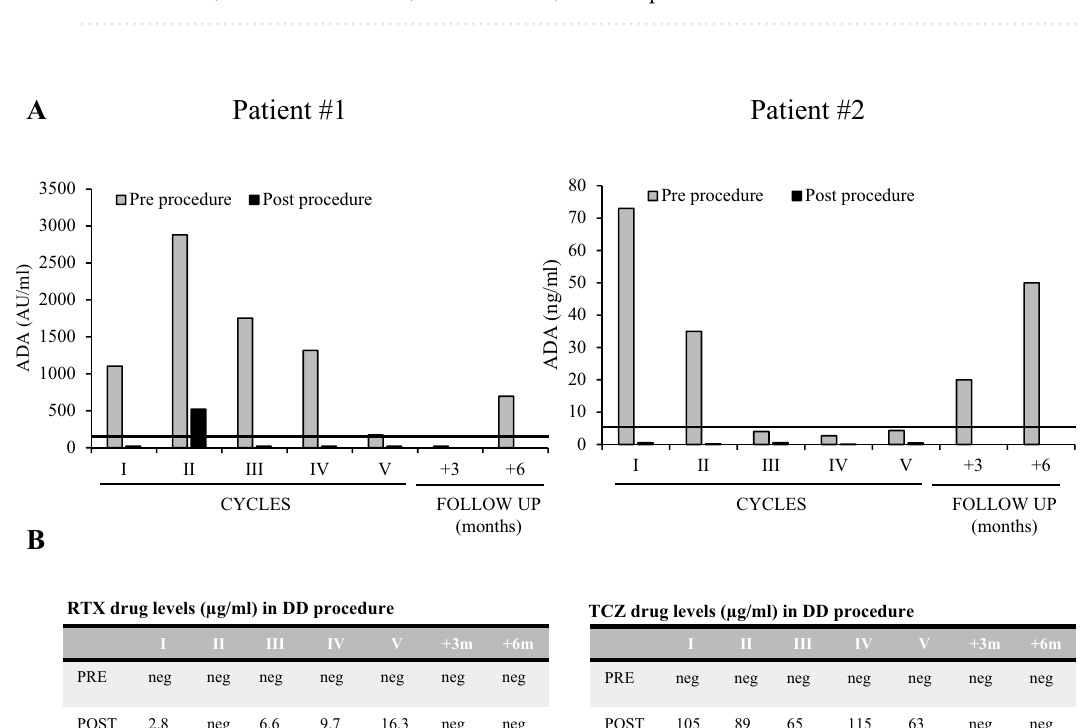
Table 1. Skin testing for rituximab and grass pollen across desensitization cycles in patient #1. DD drug desensitization, IDT intradermal test, RTX rituximab, SPT skin prick test.